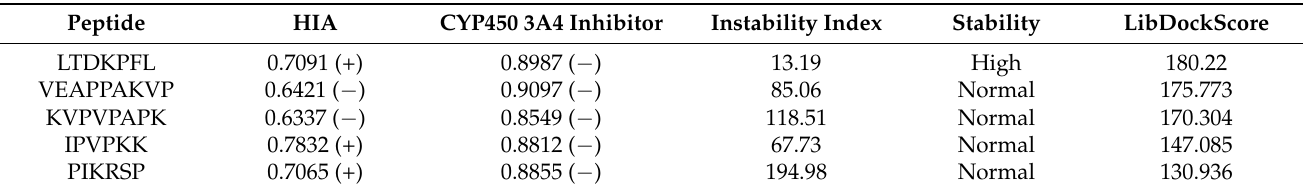
Table 3. In silico prediction of properties of the identified PAF-AH inhibitory